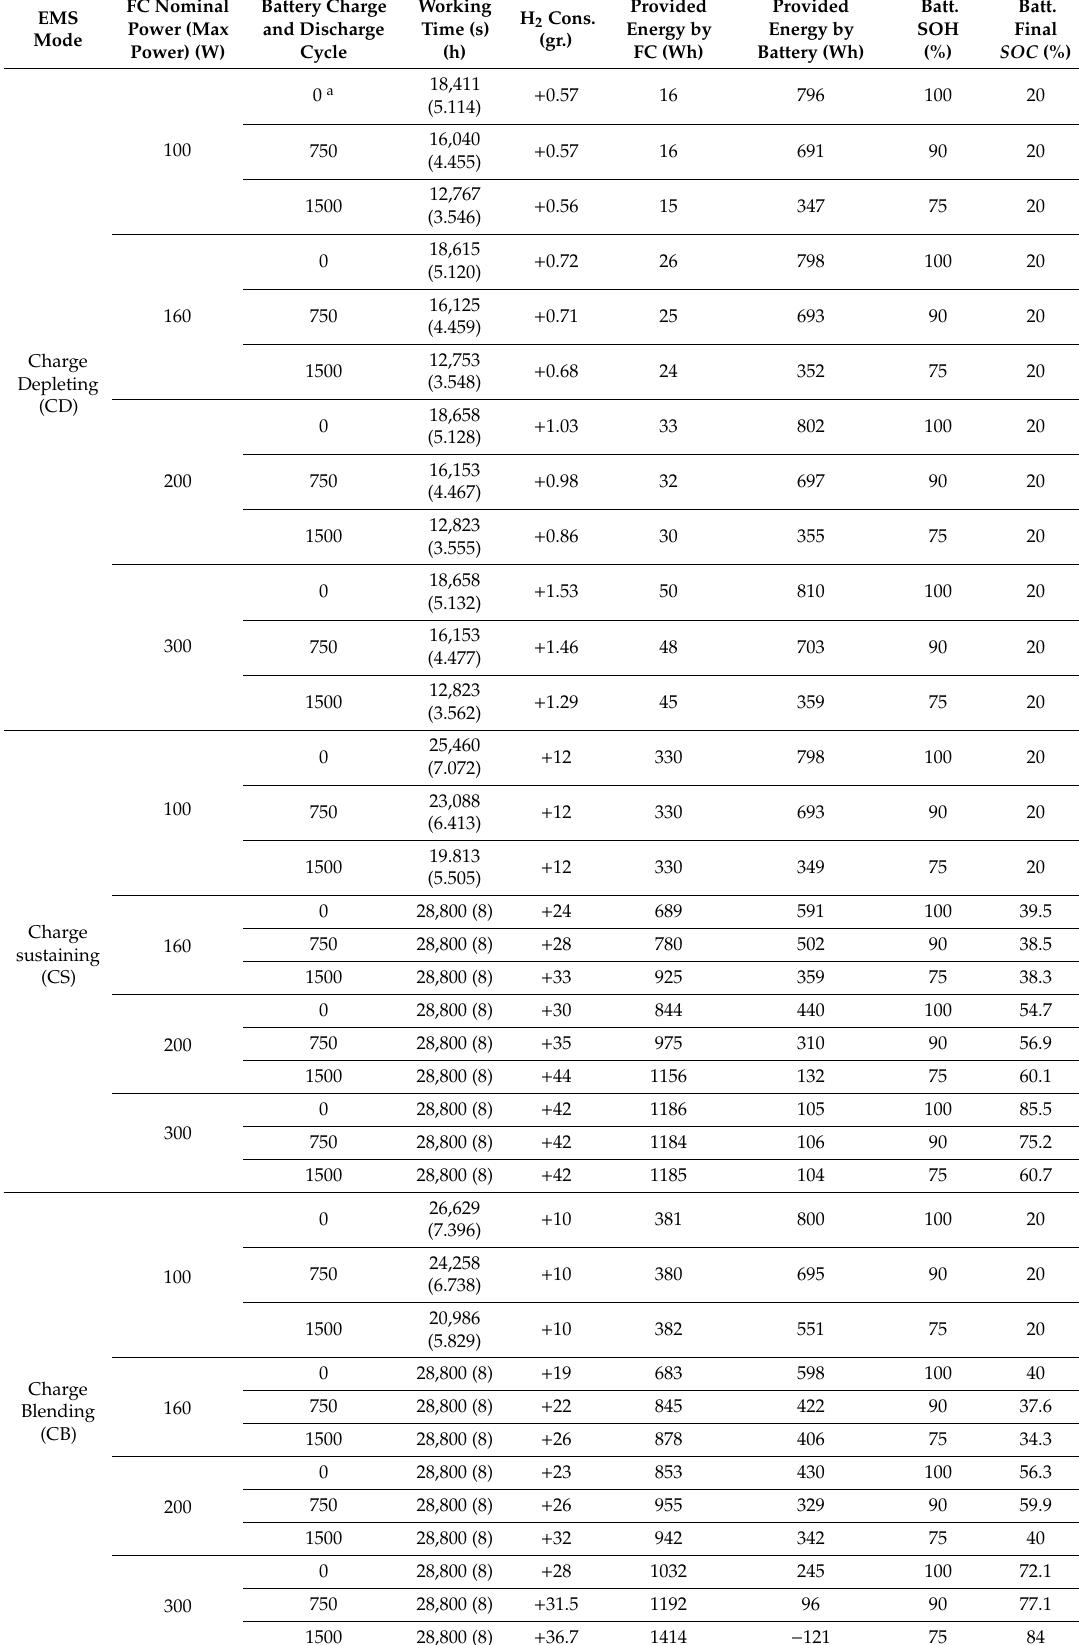
Table 5. Comparison results of energy sources with di ff erent EMS and battery